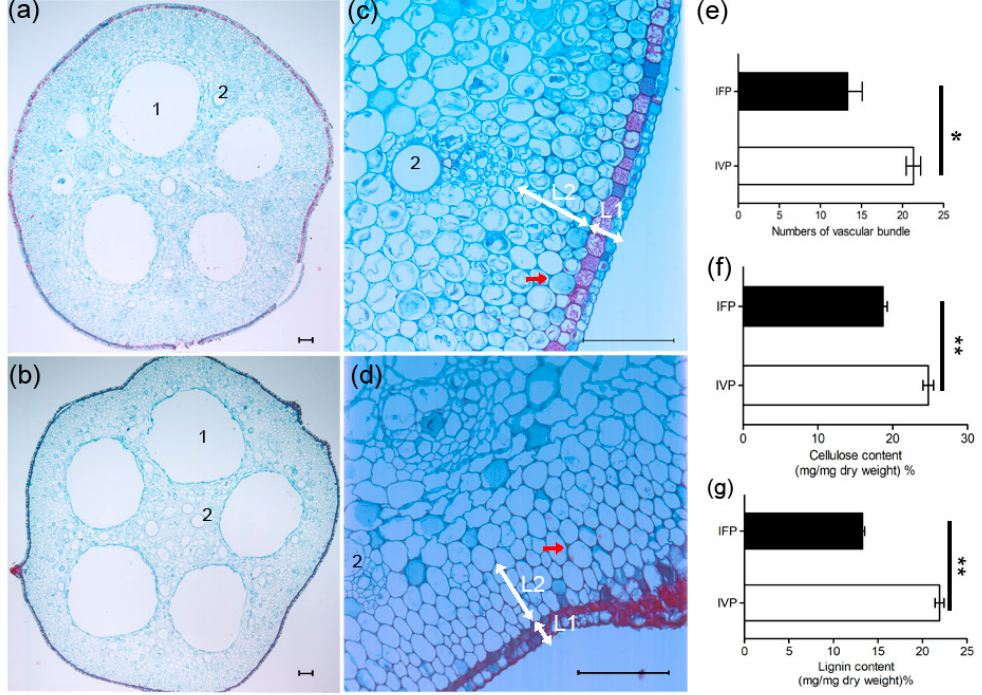
Figure 2. Transverse sections of IFP and IVP stained with fast green and the counterstain safranin. ( a , c ) and ( b , d ) show transverse sections of IFP and IVP, respectively. Arabic numerals 1 and 2 indicate big air cavities and xylem vessel. L1 and L2 indicate the epidermal and cortex. Red arrow shows collenchyma. Bars in figures indicate 100 µ m; ( e ) statistics of vascular bundles number in IFP and IVP, data are means ± SD from 10 independent transverse sections (IFP and IVP); ( f ) determination of crude cellulose and ( g ) lignin. Data are means ± SD from 3 independent biologic repeats. Asterisks and double asterisks indicate significant changes compared to the control as assessed according to Student’s t -test (* p < 0.05 and ** p < 0.01).